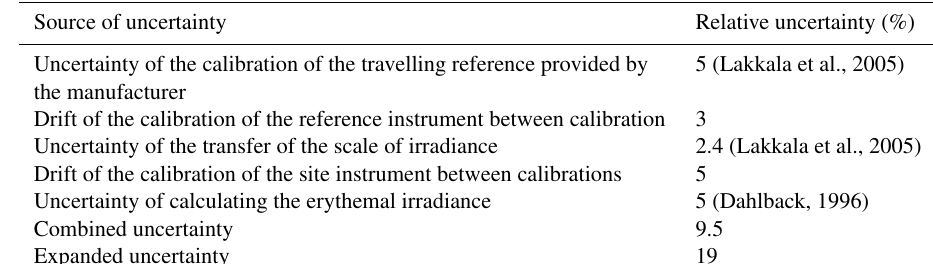
Table 3. Uncertainty budget of the erythemally weighted UV irradiances during 2000–2008. Source of uncertainty Relative uncertainty (%)